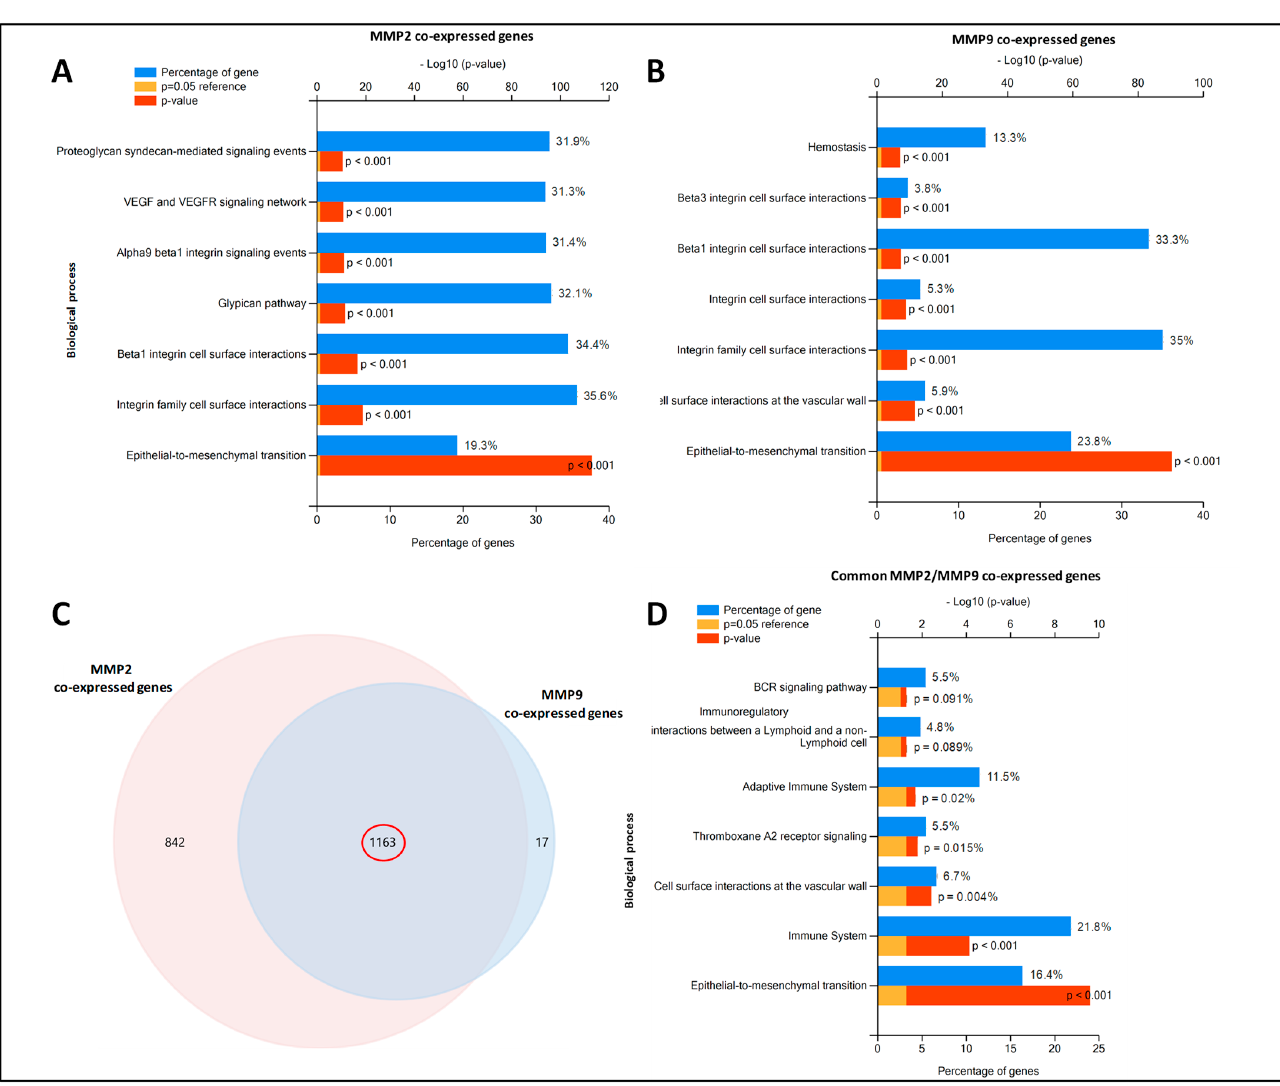
Figure 3. Enrichment pathway analysis of MMP2/MMP9 co-expressed genes retrieved by UALCAN database. ( A , B ) Significantly enriched biological pathways were ranked by p -value using the FunRich 3.0 software. For each biological pathway, the percentage of proteins and their p -values (Benjamini–Hochberg correction) are indicated. Common pathways between MMP2 and MMP9 co-expressed genes are highlighted with different color squares. ( C ) Venn diagram of overlapping MMP2/MMP9 co-expressed genes. ( D ) Significantly enriched biological pathways of overlapping MMP2/MMP9 co- expressed genes, ranked by p